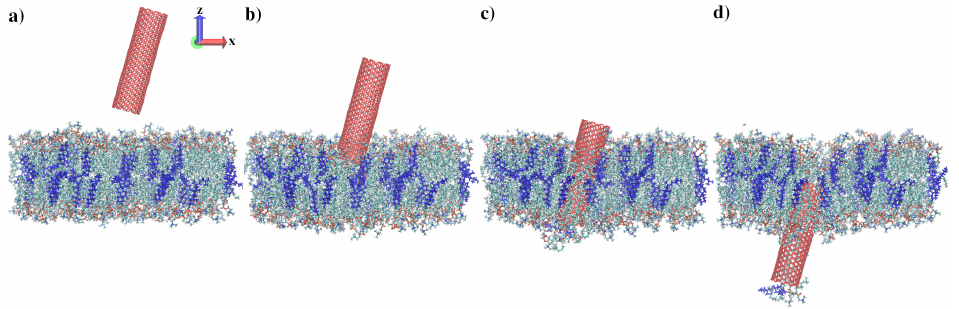
Figure 1. A series of snapshots visualizing tube-axis membrane indentation for CNT, 15 ◦ , and v = 2.0 m/s. Cholesterol molecules inside the DMPC membrane are dark blue. ( a ) CNT initial stage (after equilibration); CNT indenter tip is at: ( b ) z = − 25 Å, ( c ) z = − 55 Å, ( d ) z = − 85